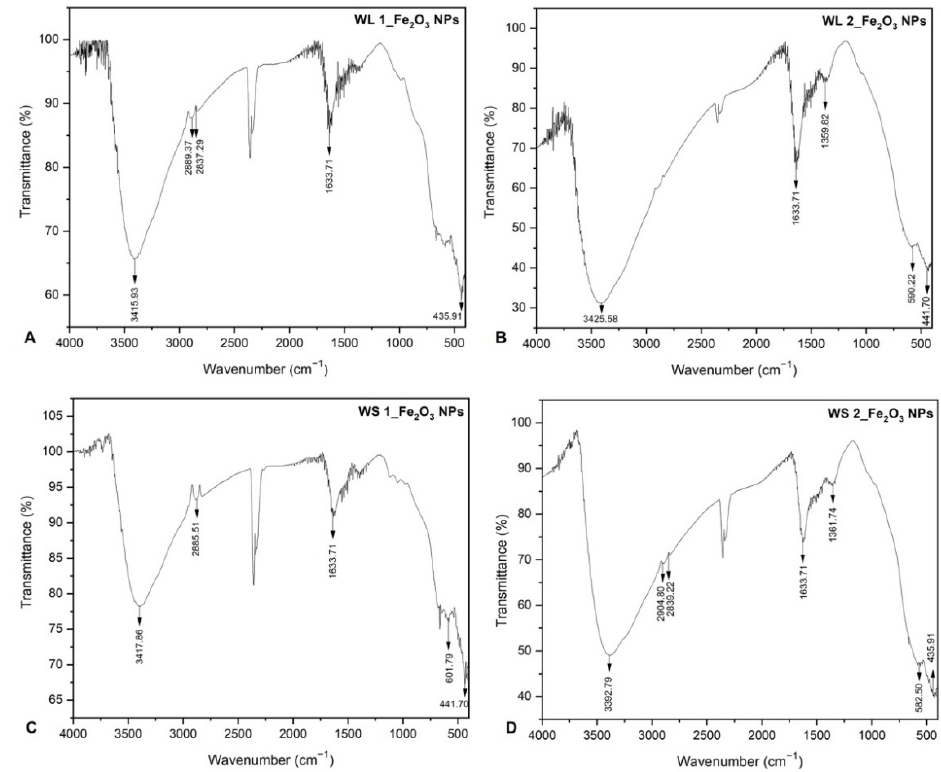
Figure 4. FTIR spectrum of IONPs obtained by green synthesis; ( A ) Fe 2 O 3 NPs from WL at 80 °C, ( B ) Fe 2 O 3 NPs from WL at 25 °C, ( C ) Fe 2 O 3 NPs from WS at 80 °C, ( D ) Fe 2 O 3 NPs from WS at 25 °C.